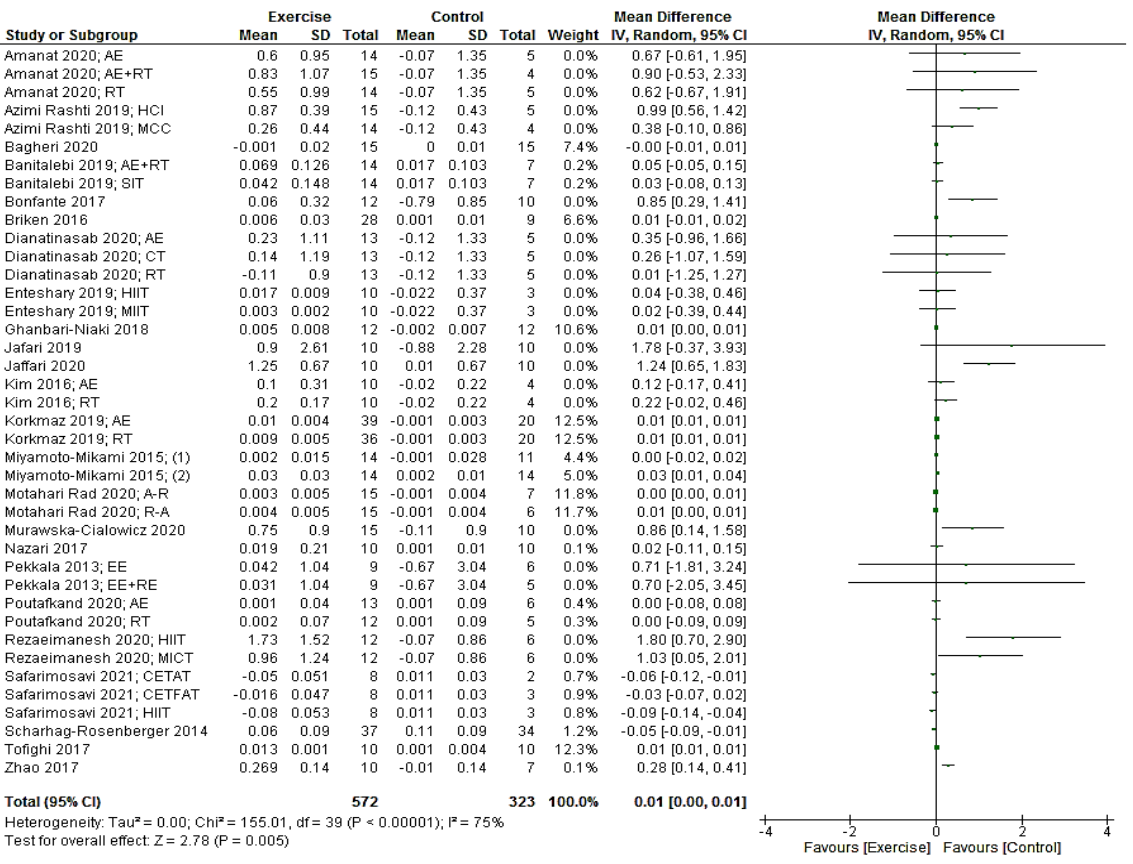
Figure 2: Forest plot of the effects of exercise training versus control on irisin. AE, aerobic; RT, re- sistance training; HCI, high-intensity concurrent interval; MCC, moderate-intensity concurrent contin- ues; SIT, sprint interval training; HIIT. High intensity interval training; A-R, aerobic-resistance; R-A, re- sistance-aerobic; EE, endurance exercise; CETFAT, continuous endurance training with intensity equivalent to Fatmax (maximal fat oxidation); CETAT, continuous endurance training with intensity equivalent to anaerobic